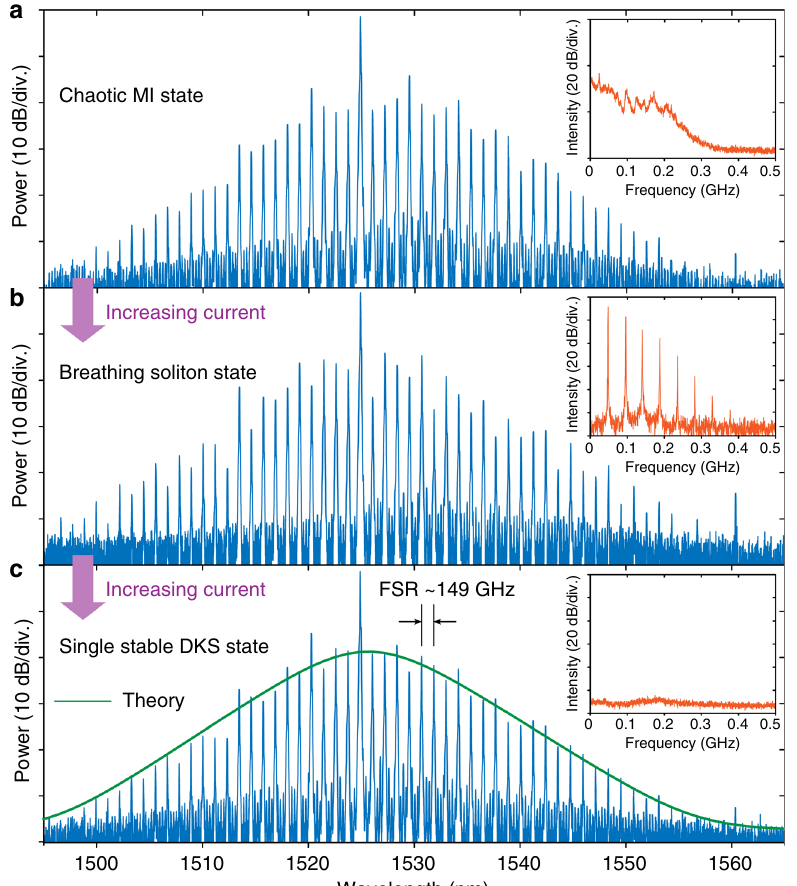
Fig. 3 Soliton comb generation with self-injection locking. Evolution of Kerr frequency comb in the regime of laser self-injection locking, from noisy state in the operation regime of modulation instability (MI) ( a ) to breathing state ( b ), and eventually to a low-noise state ( c ) showing the formation of a dissipative Kerr soliton (DKS) in the microresonator, where the spectrum is a hyperbolic secant envelope (green-solid line showing the fi tting of the spectral envelope). Each inset shows the low-frequency radio frequency (RF) spectrum corresponding to each state. The current imposed to the diode is initially set ~300 mA and the increase to evoke the transitions is within 1 mA. The Si 3 N 4 microresonator in this measurement has a free spectral range (FSR) of